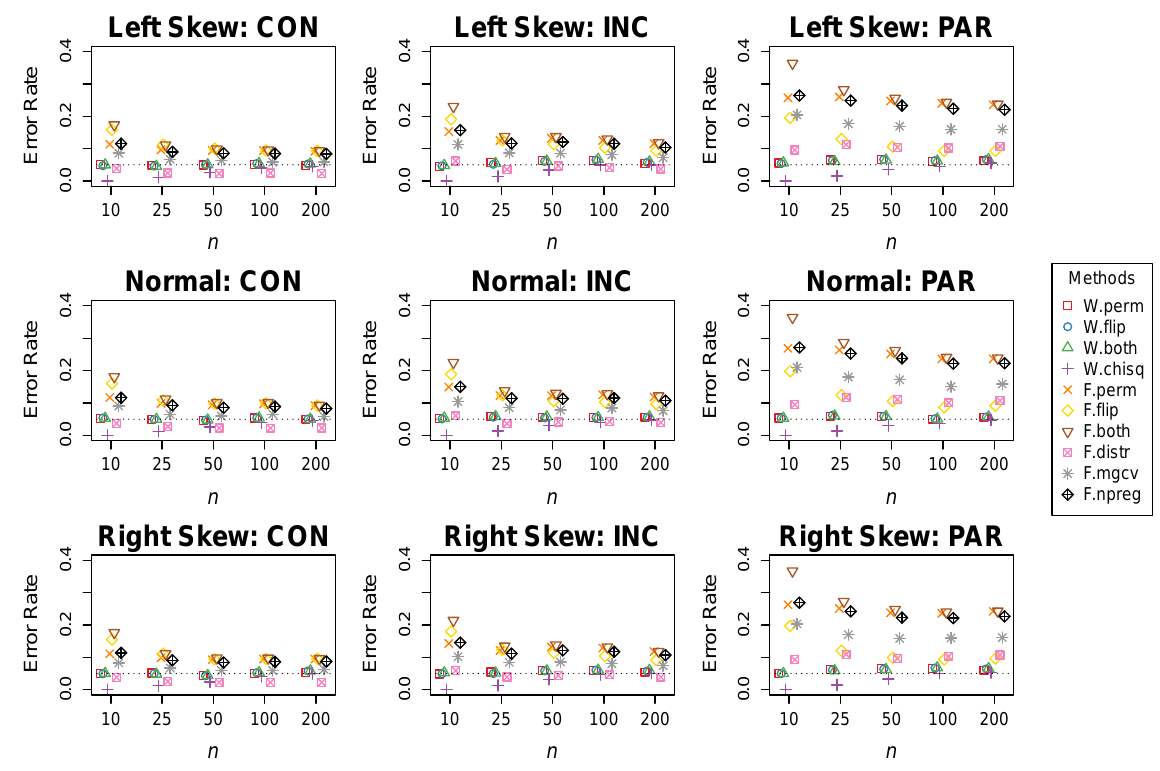
Figure 2. Simulation A Results. Within each subplot, the Type I error rate is plotted for each inference method at each sample size. The rows denote the three different data generating distributions, and the columns denote the three different error standard deviation functions. The nominal α = 0.05 rate is denoted with a dotted